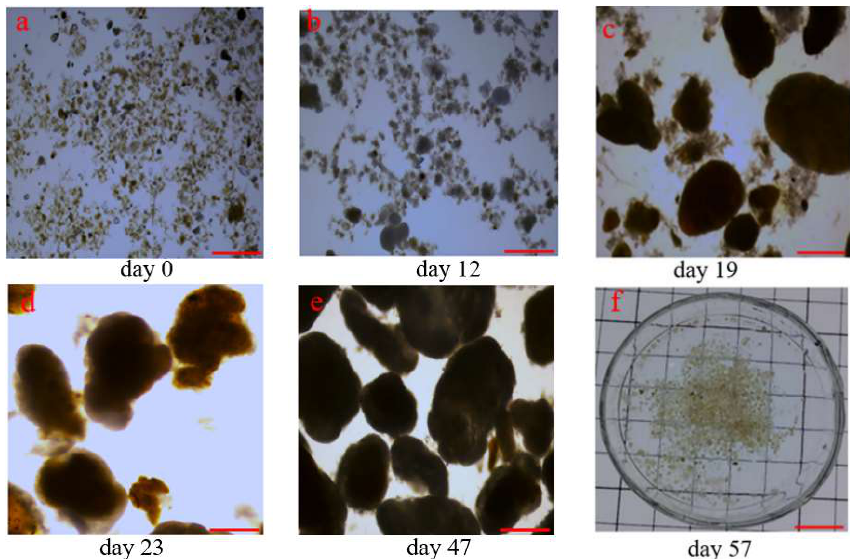
Figure 3. Photographs of the granular sludge during the rapid granulation process; scale bars = 1 cm.